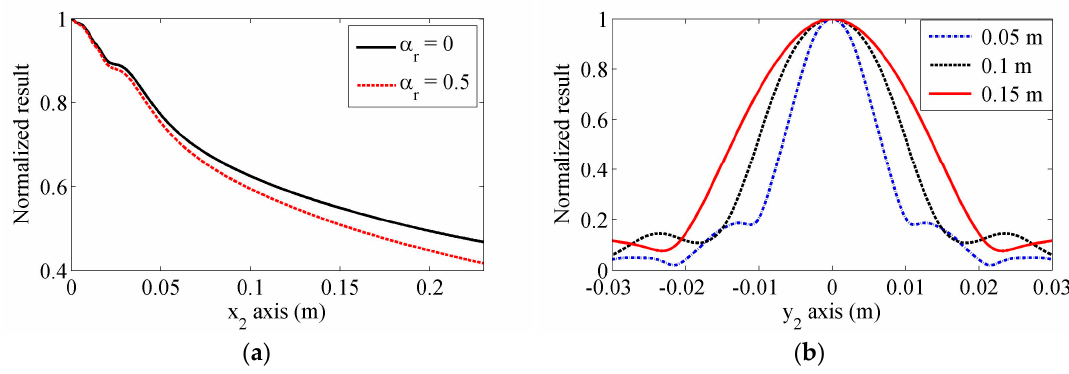
Figure 7. Normalized Rayleigh wave beam magnitudes along ( a ) x 2 -axis, and ( b ) y 2 -axis. Different Rayleigh wave attenuation coefficients are used in ( a ), but attenuation is neglected in ( b ).